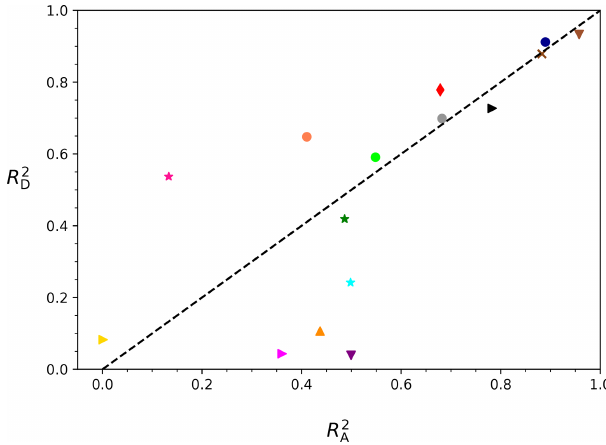
Figure 7. The correlation coefficients R 2 vs. A ) from M b are shown for the 15 shape groups. For a legend of the shape groups, see Fig. 5. The dashed black line represents = R 2 R 2 D A